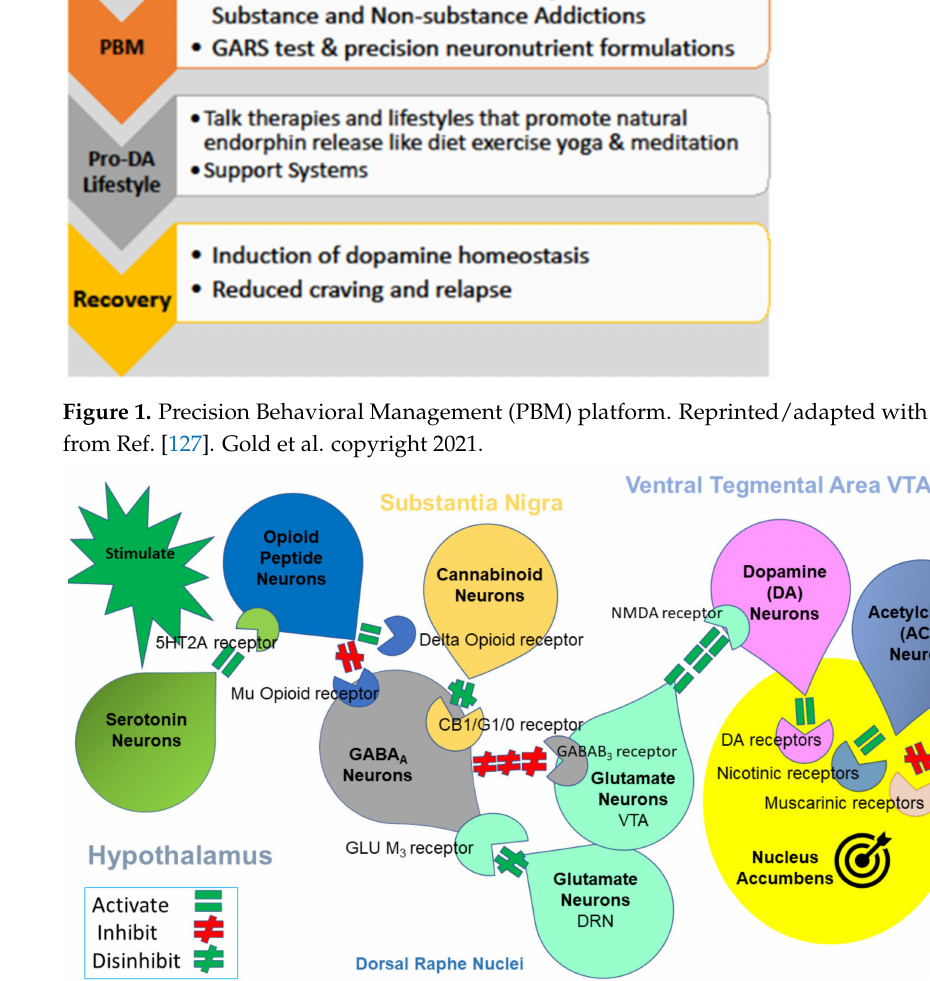
Figure 2. Mesolimbic Brain Reward Cascade [128]. This cartoon illustrates the interaction of the known major neurotransmitter pathways involved in the Brain Reward Cascade (BRC). In the hypothalamus, environmental stimulation results in the release of serotonin, which in turn, via, for example, 5HT-2a receptors, activates (green equal sign) the subsequent release of opioid peptides from opioid peptide neurons. Then, Substantia Nigra, the opioid peptides move to possibly two different opioid receptors with different effects. One inhibits (red hash sign) through the mu-opioid receptor (possibly via enkephalin) to GABA A neurons. Another stimulates (green equal sign) cannabinoid neurons (the Anandamide and 2-archydonoglcerol, for example) through beta-endorphin-linked delta receptors, which inhibit GABA A neurons. In addition, when activated, cannabinoids, primarily 2-archydonoglerol, can indirectly disinhibit (green hash sign) GABA A neurons through the activation of G1/0 coupled to CB1 receptors. In the Dorsal Raphe Nuclei (DRN), glutamate neurons can then indirectly disinhibit GABA A neurons in the Substantia Nigra through activation of GLU M 3 receptors (green hash sign). GABA A neurons, when disinhibited, will, in turn, powerfully (red hash signs) inhibit VTA glutaminergic drive via GABAB 3 receptors. At the Nucleus, Accumbens ACH neurons may stimulate both muscarinic (red hash) and nicotinic (green hash). Finally, glutamate neurons in the VTA will project to dopamine neurons through NMDA receptors (green equal sign) to preferentially release dopamine at the Nucleus Accumbens (NAc), shown as a bullseye, indicating a euphoria, or “wanting” response. The result is dopamine release; low release is (endorphin deficiency), and unhappiness is felt. General (healthy) happiness depends on the dopamine homeostatic tonic set point (with permission) [22]. Notably, various hypotheses have explained the findings that led to the modern known correlates of neurotransmitter interactions within this brain reward